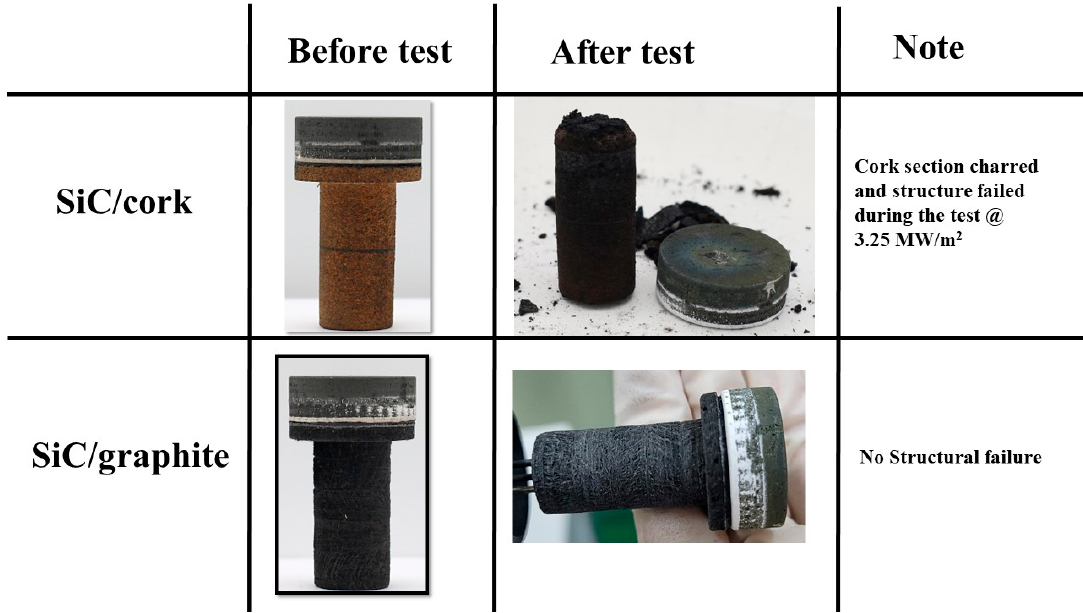
Figure 22. SiC-coated C–C specimens’ before and after test images (side view).